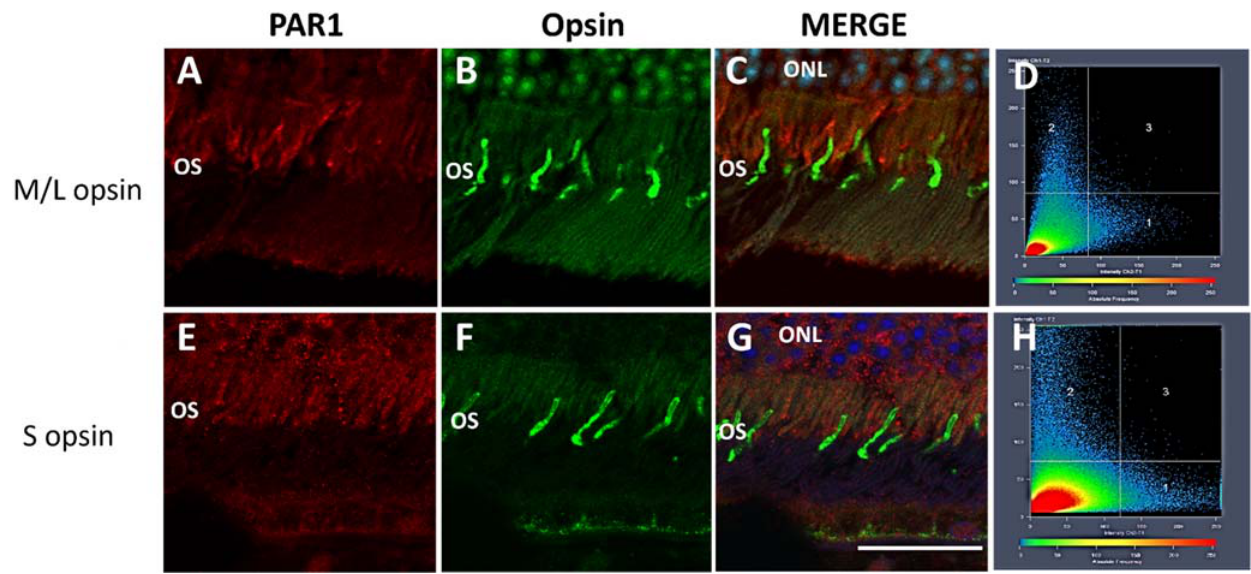
Figure 3. PAR1 does not co-localize with cone L/M-opsin and S-opsin in mouse retina. A rep- resentative image of paraffin cross sections of retinas derived from C57BL/6J mice stained with anti-PAR1 (red, A , C , E , G ), L/M opsin (green, B , C ), and S opsin (green, F , G ) antibodies. Nuclei were counter-stained with DAPI (blue, C , G ). Images were obtained with a confocal microscope (LSM700). ONL: outer nuclear layer, OS: (photoreceptor) outer segments. ( D , H ) Co-localization analysis was performed in three areas of retinal sections derived from two mice (n = 2). Scale bar: 25 µ m.